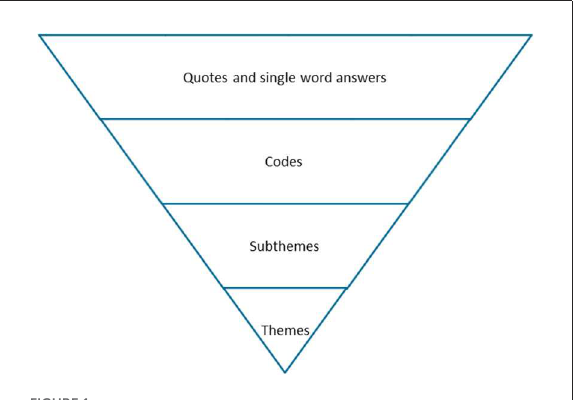
FIGURE1 Schematic overview of the qualitative steps of our analysis.